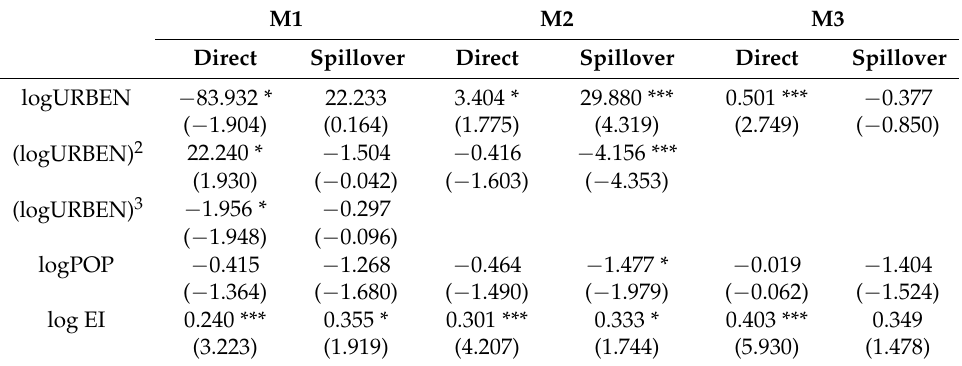
Table 7. Direct and spillover effects estimation (Urbanization as the indicator of